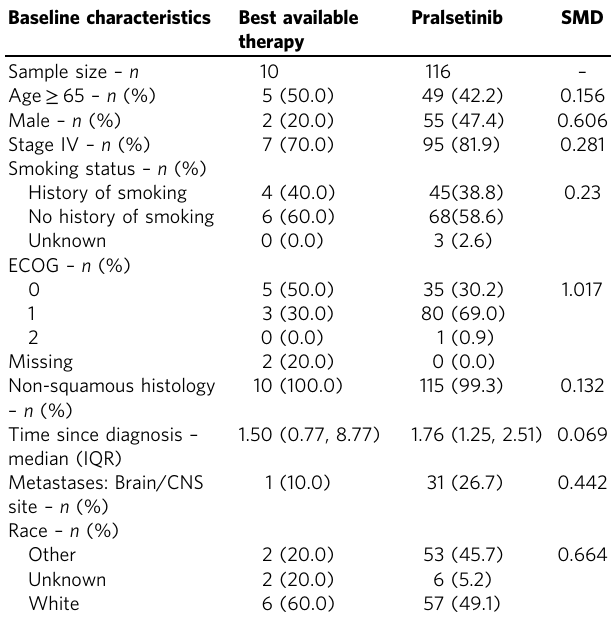
Table 1 Baseline characteristics of the 1 L ARROW trial participants given pralsetinib and 1 L CGDB cohort given the best available therapy without